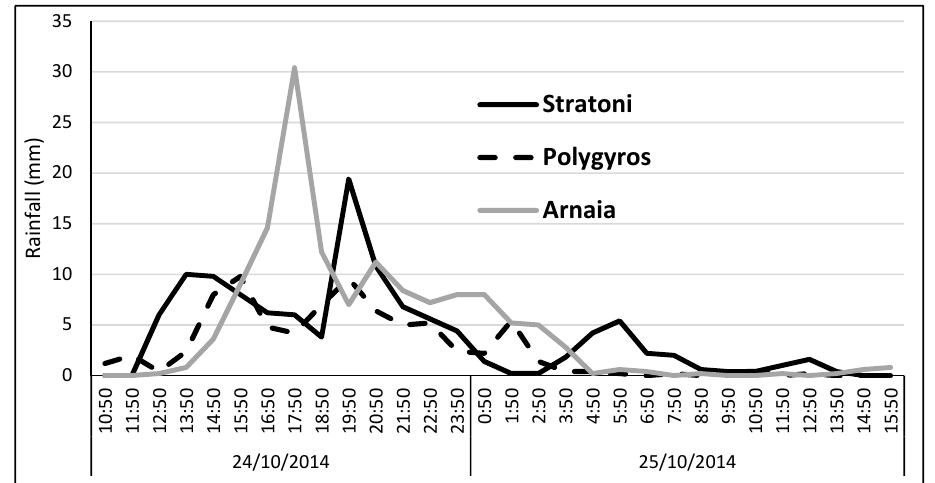
Figure 6. Rainfall intensity at Stratoni, Polygyros, and Arnaia observatories during the September 2014 event.